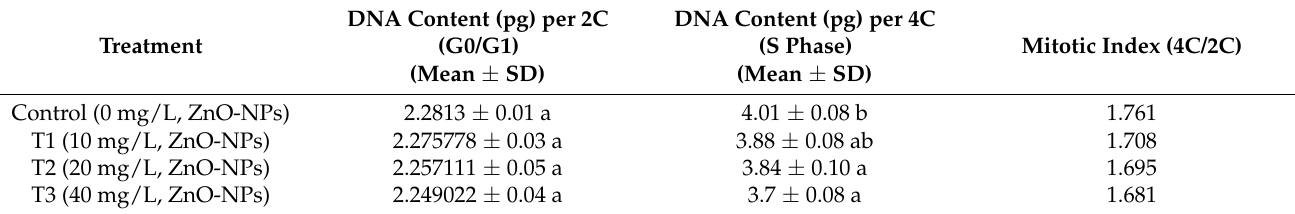
Table 1. Genome size (2C and 4C DNA content) and mitotic index calculated from generated histogram using